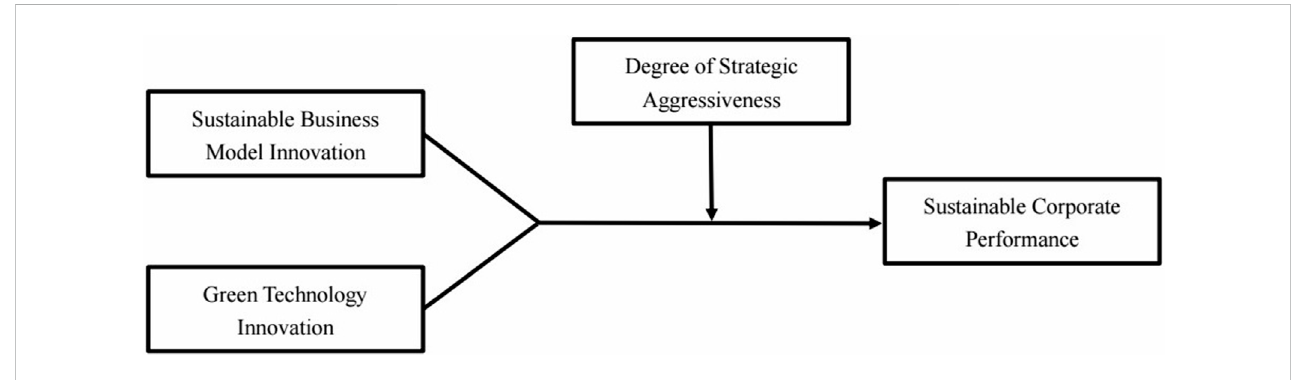
FIGURE 2 Conceptual model of this